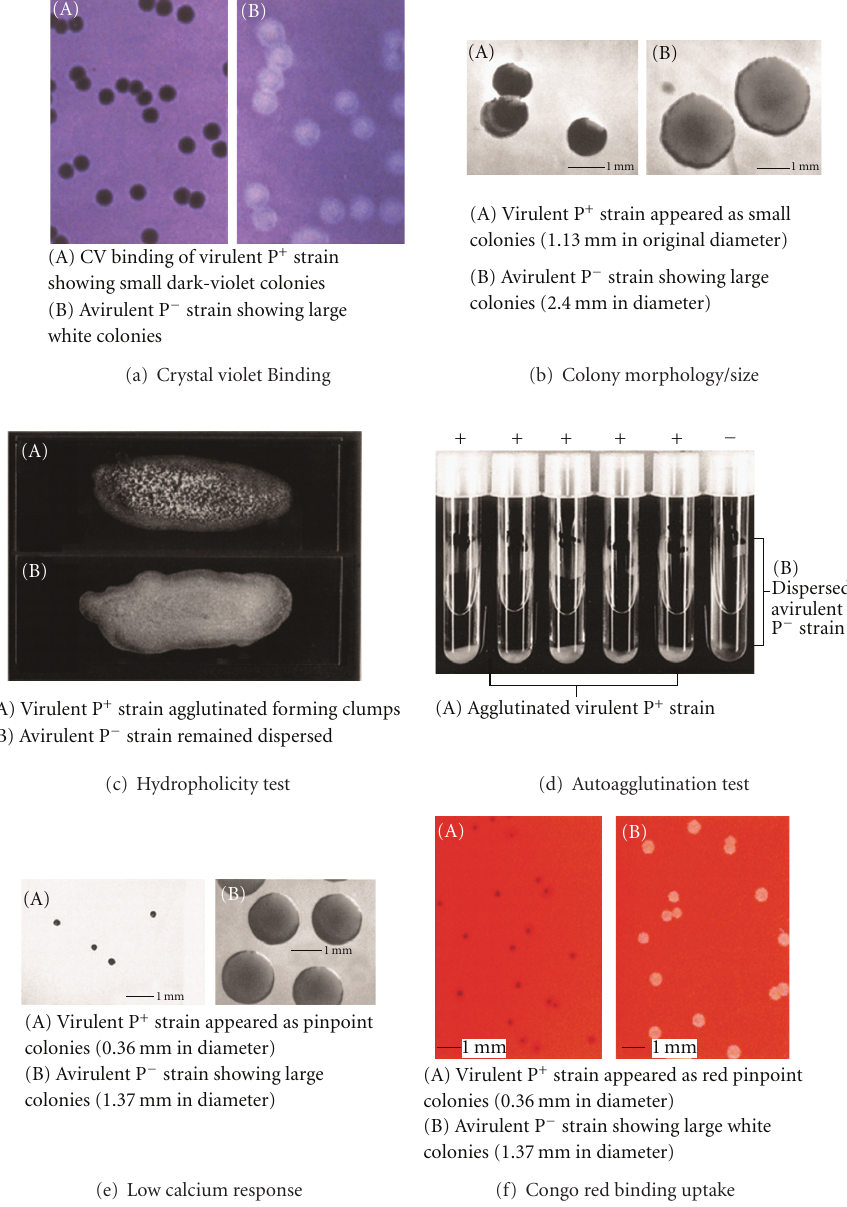
Figure 2: Evaluation of pYV-associated virulent phenotypes of pathogenic Yersinia species